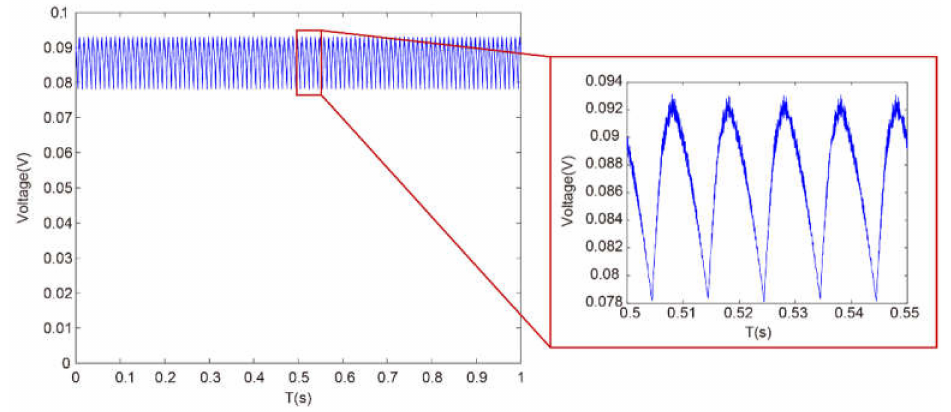
Figure 12. Measurements of